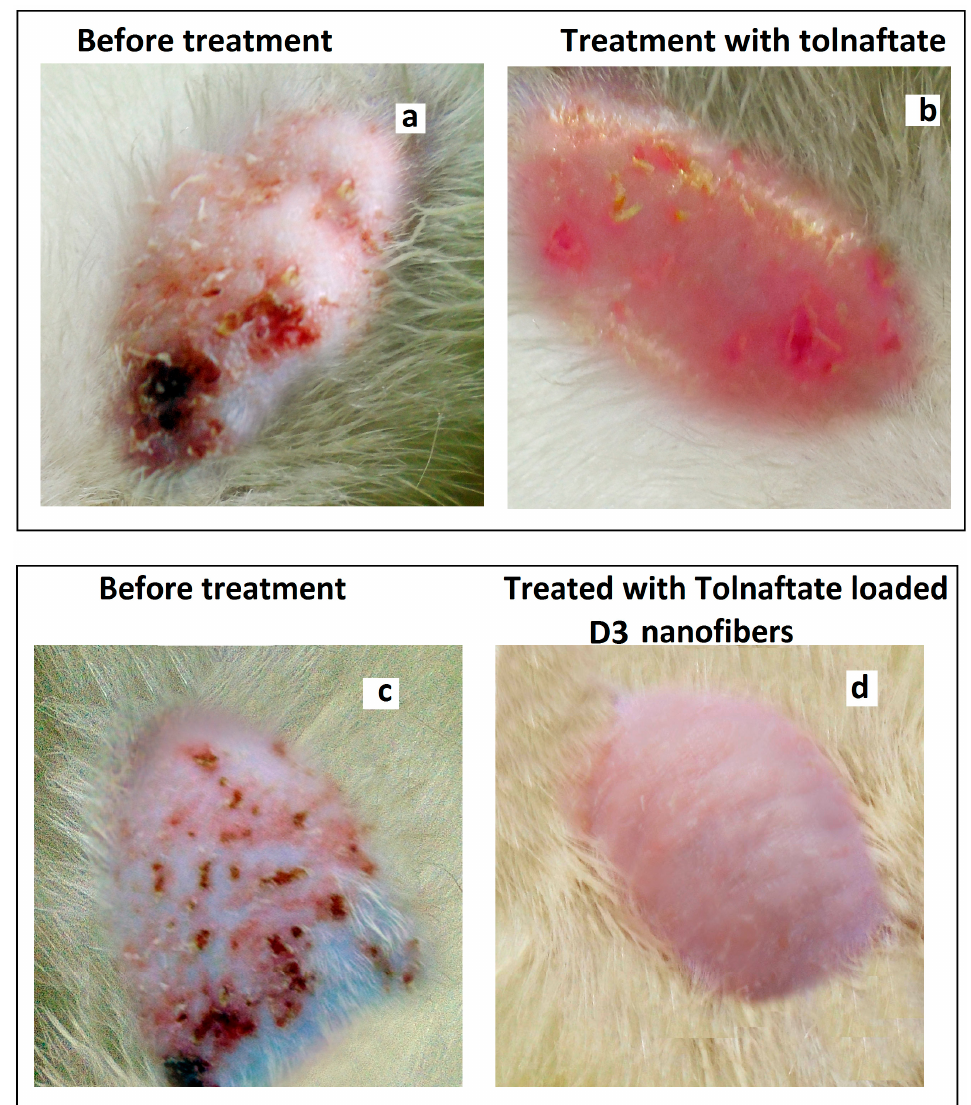
Figure 7. In vivo study on Swiss albino mice infected by T. rubrum dermatophyte ( a , c ); treatment with the tolnaftate drug and tolnaftate-loaded nanofibers ( b , d ) respectively.